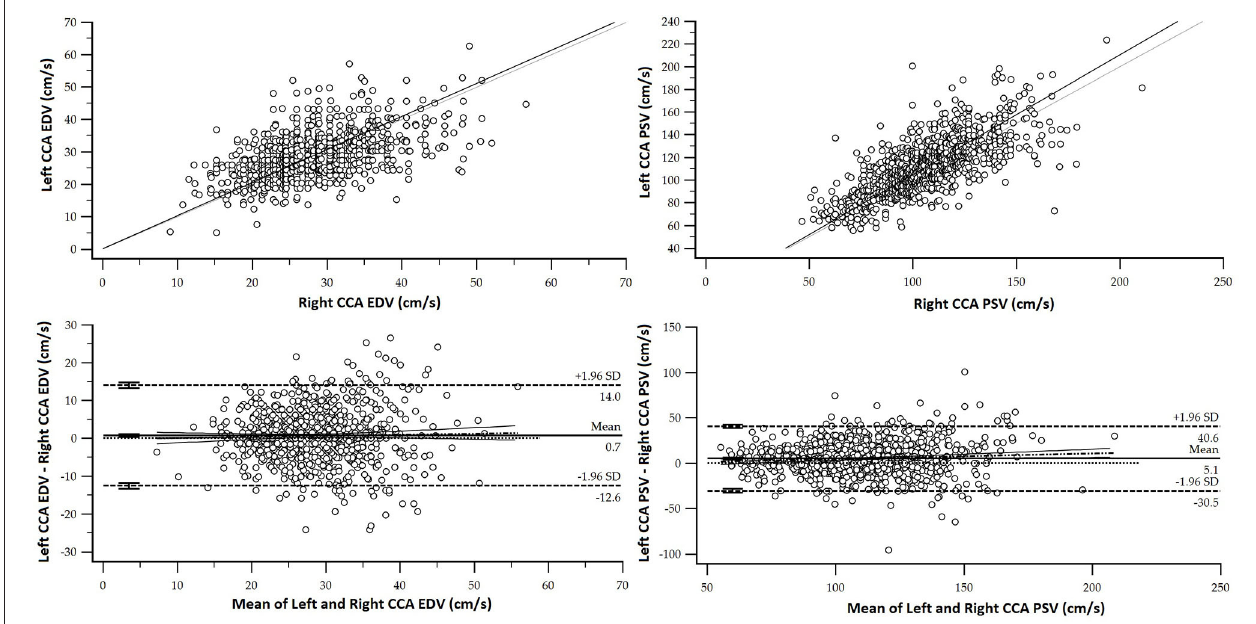
FIGURE 3 | Top. Association (scatter diagram) between left and right CCA and EDV and PSV for the RIs subgroup. Bottom. Bland–Altman diagram. There were significant mean (EDV: 0.71 cm/s and PSV: 5.09 cm/s) and proportional errors.